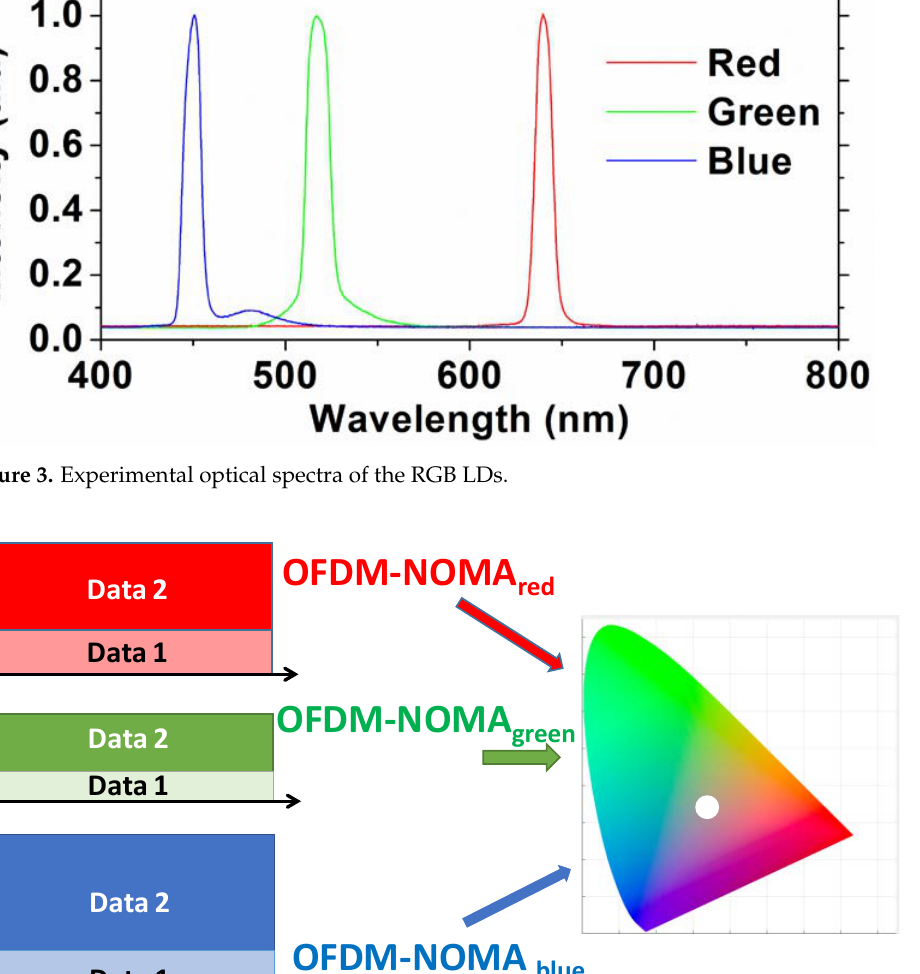
Figure 5. Experimentally measured CIE 1931 chromaticity color gamut at different driving currents for the RGB LDs respectively; showing colors of ( a ) red, ( b ) green, ( c ) blue and ( d ) white . Insets: photos of the color generated.